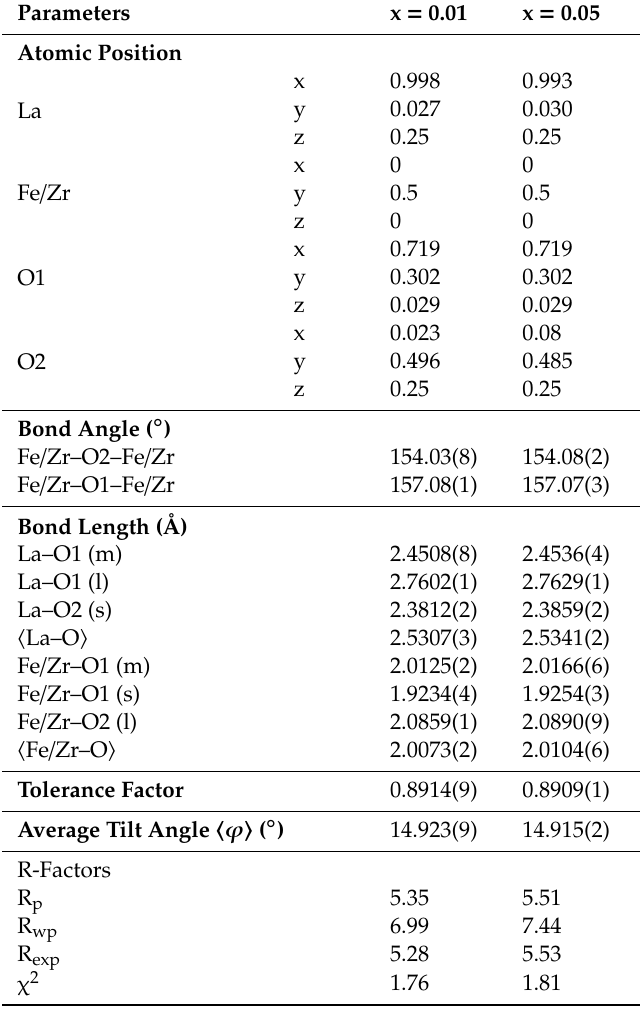
Table 3. Geometrical parameters characterizing the crystal structure of LaFe 1 − x Zr x O 3 annealed at 800 ◦ C for 6 h.